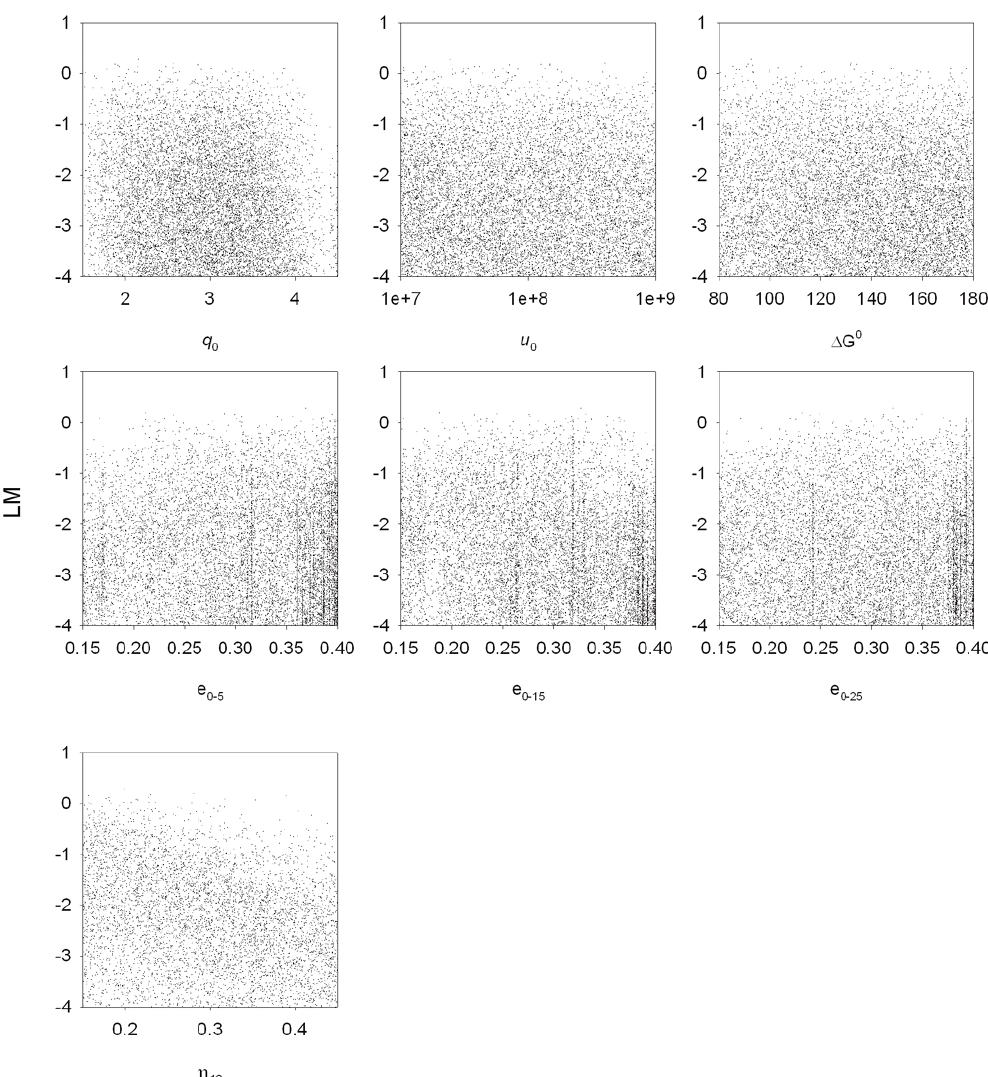
Fig. 4. Dotty plots for the one initial quality, flexible decomposer efficiency. Each dot represents one model run. The likelihood measure, LM, or “goodness of fit”, is plotted against parameter values. The x-scales cover the allowed ranges of the parameters. Parameter sets resulting in a LM > 0 where used in ensemble simulation